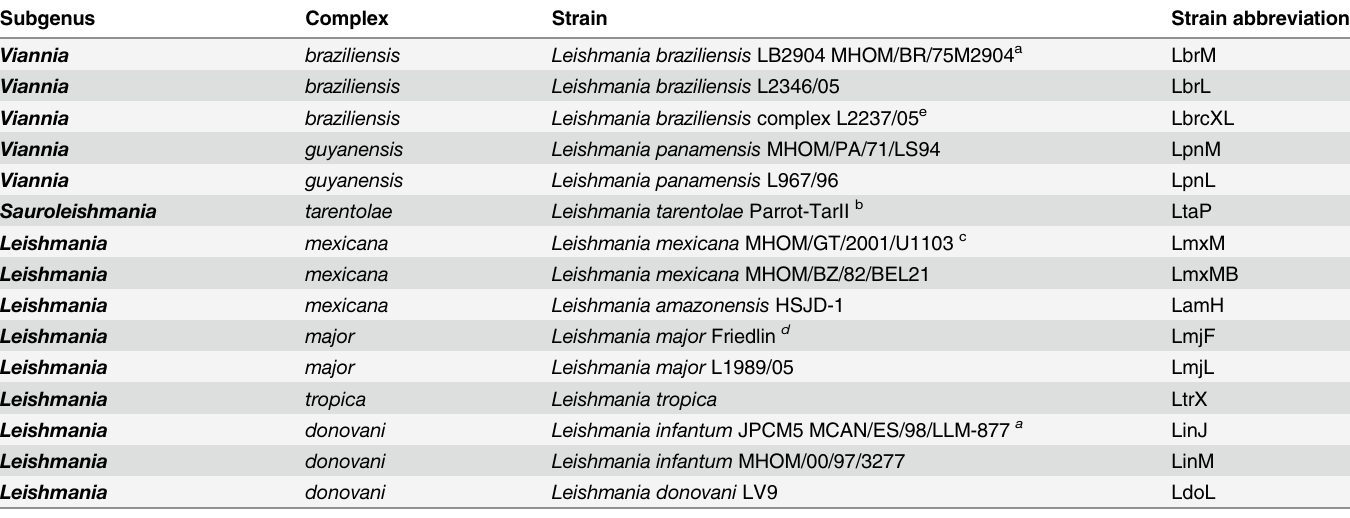
Table 1. Strains of Leishmania included in this